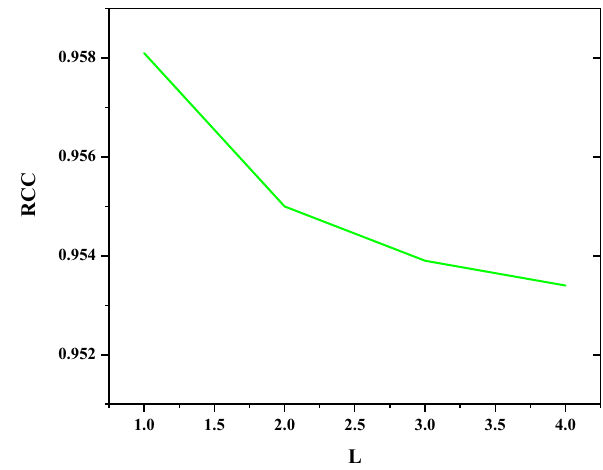
Figure 5: P – M di ff usion ( RCC ) based on gradient automatic threshold